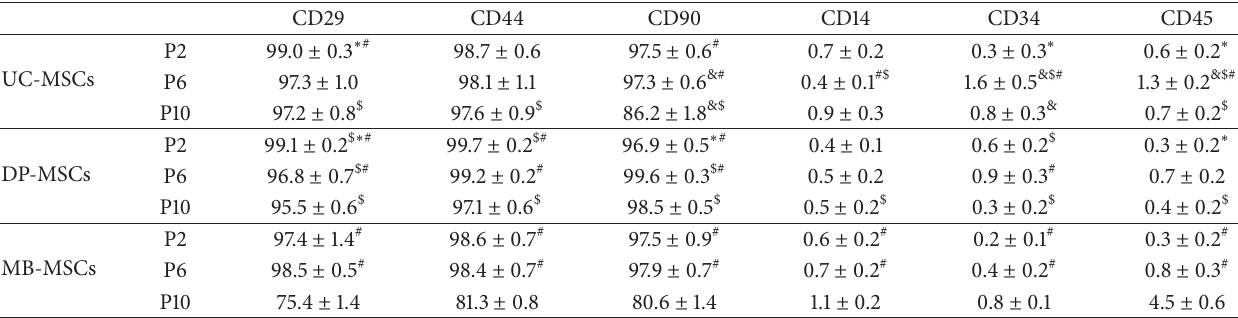
Table 1: Comparison of surface markers of UC-MSCs, DP-MSCs, and MB-MSCs.